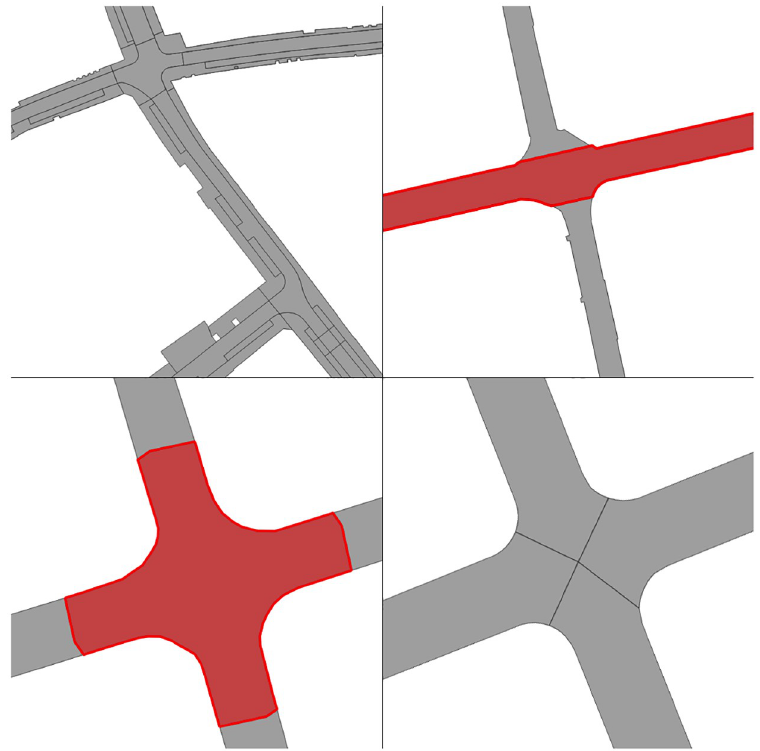
Fig 13. The different approaches to modelling intersections, clockwise from top left: The Hague, Helsinki, Shawinigan, and Toronto.